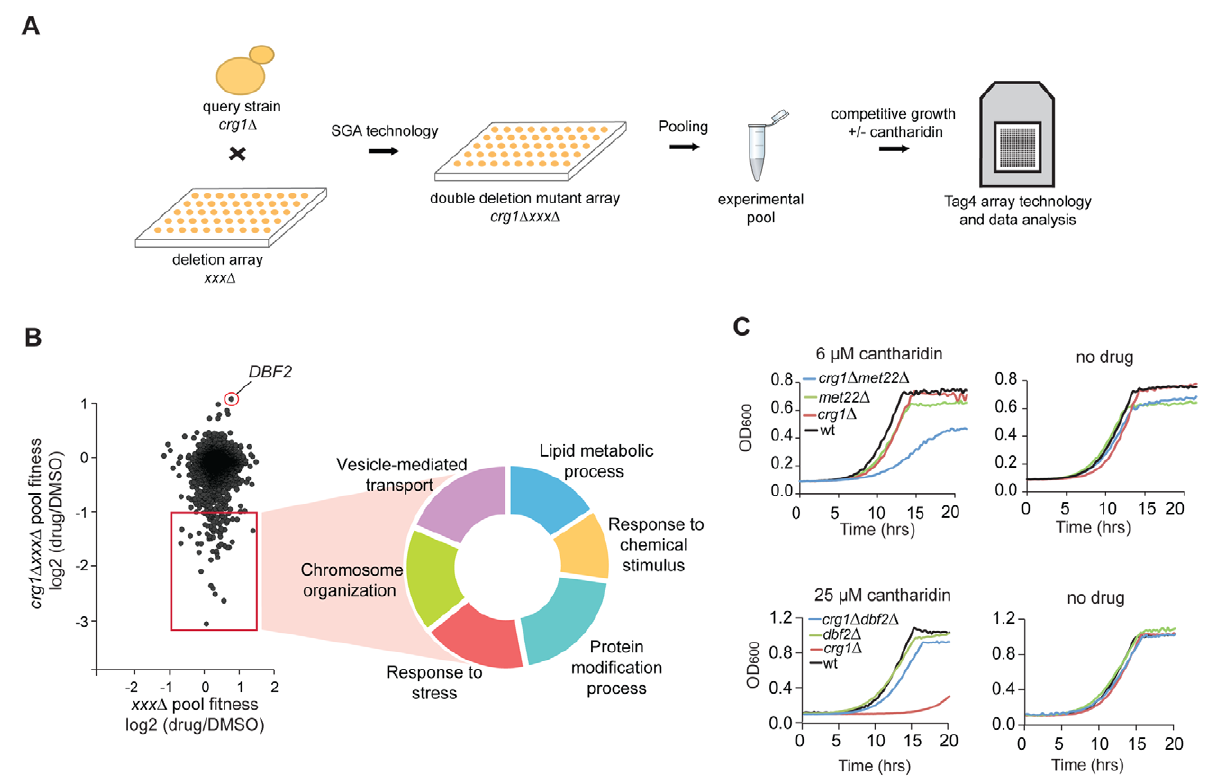
Figure 4. Characterization of cantharidin-specific genetic interactome of CRG1 . (A) Experimental scheme for analysis of cantharidin-specific genetic interactors of CRG1 . Double deletion mutants crg1 D xxx D generated through Synthetic Genetic Array (SGA) were pooled together and treated with cantharidin (30 m M) for 20 generations in YPD. Genomic DNA was isolated, unique strain-representative barcodes were PCR amplified, and the PCR products were hybridized to TAG4 arrays for the quantitative analysis of fitness of the mutants (see Materials and Methods for details). (B) Scatter plot representing cantharidin-gene interactions obtained from the comparative analysis of ura3 D xxx D (control single deletion pool) and crg1 D xxx D pools. CRG1 -dependent interactors are highlighted in the red square. The hits are obtained from the averaged datasets (n=6 for crg1 D xxx D pools and n=4 for ura3 D xxx D ). Significant negative genetic interactors were categorized according to their biological processes ( P -value , 0.002 before multiple testing correction) (Table S3). (C) Representative growth curves for the top hits (sensitive and resistant) that genetically interact with CRG1 in the presence of cantharidin. Cells were grown in YPD media with and without cantharidin. met22 and dbf2 deletion strains were treated with cantharidin to test their sensitivity and resistance,